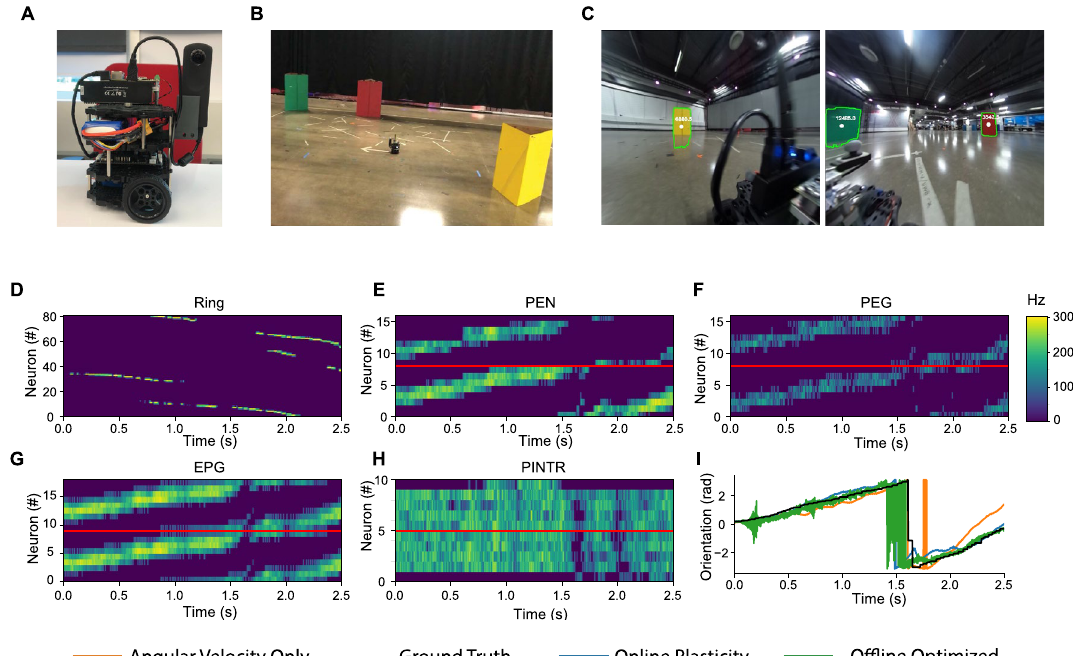
Figure 4. Model utilized with a robotic platform. ( A ) Modified Robotis Turtlebot3 “Burger,” equipped with a Nvidia Jetson TX2, and a Ricoh Theta S 360° camera. ( B ) Physical arena with colored landmark cues. ( C ) Example camera measurements with blob detection utilized to drive activation of visual neurons. ( D–H ) Neuron activation over time in each population driven by processed sensory data from the robotic platform, where visual landmark features encoded in ring neurons ( D ) drive shift in activity bump in E-PG neurons ( G ) in model configuration with online plasticity. ( I ) The estimated orientation from each model configuration (best seed) tracks the ground truth orientation with errors in the offline optimized weights at periods of prolonged visual